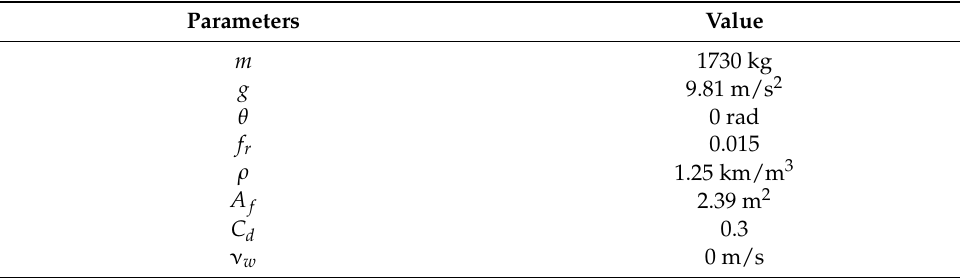
Table 1. Parameter for power demand calculation.